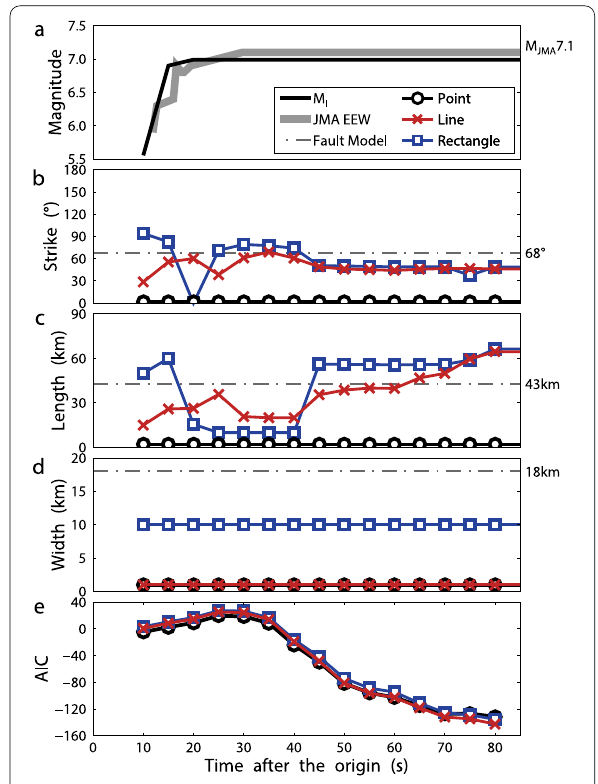
Fig. 13 Time history of the source parameters for the 2016 Kumamoto earthquake. The format is the same as in Fig.